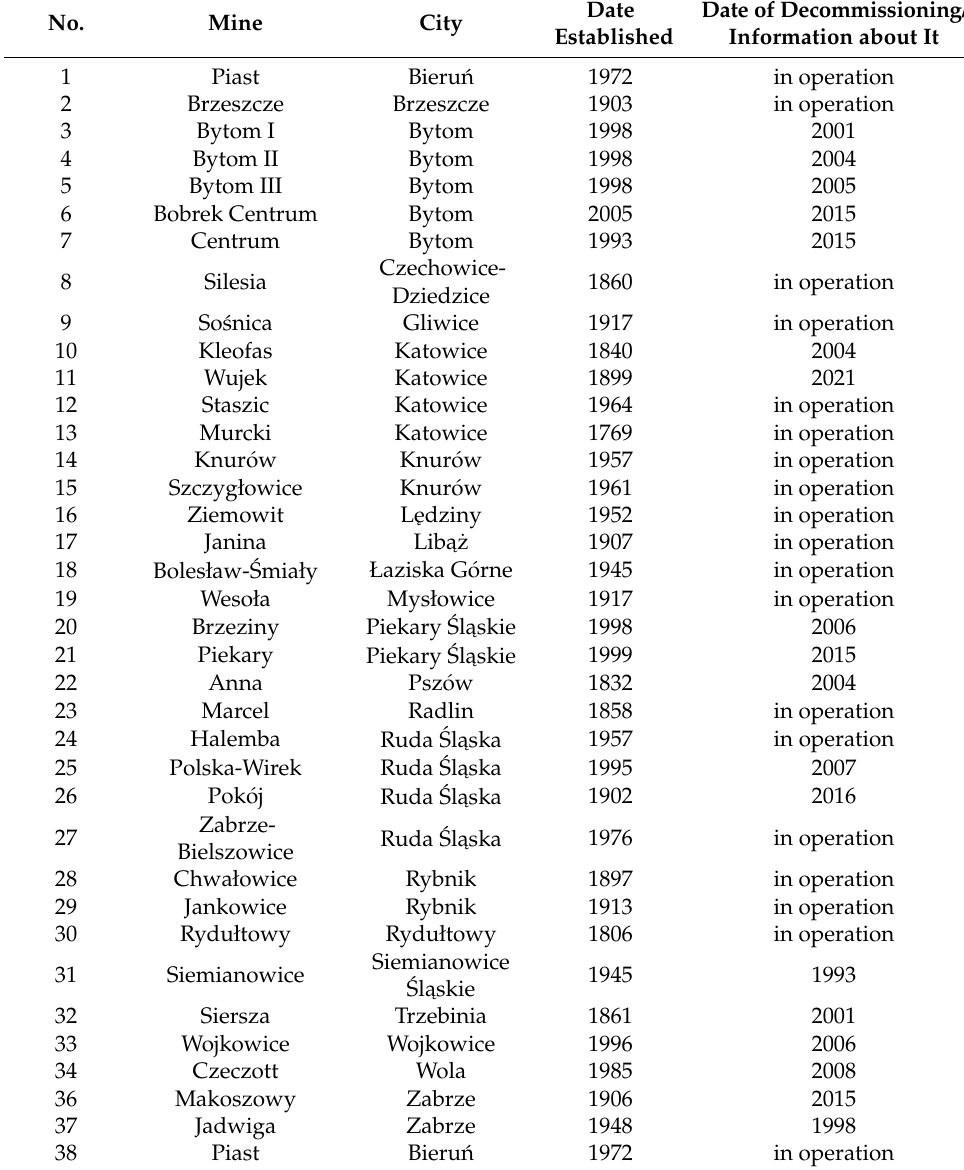
Table 1. List of hard coal mines in the Upper Silesian Coal Basin